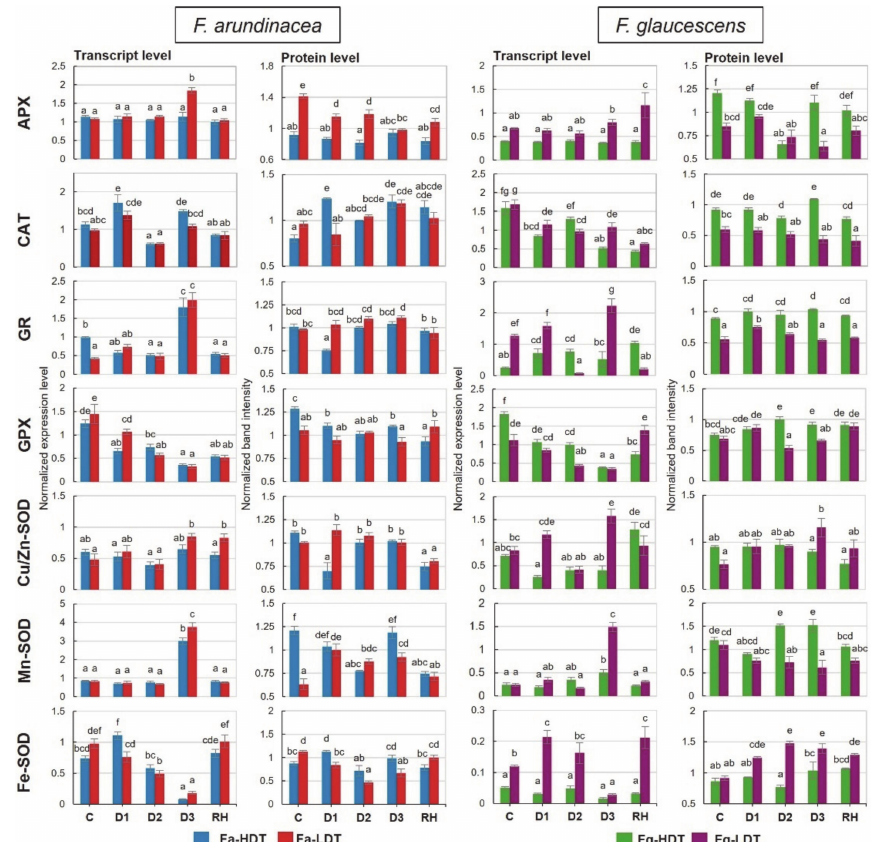
Figure 3. Transcript and protein accumulation level of L-ascorbate peroxidase ( APX ), catalase ( CAT ), glutathione reductase ( GR ), glutathione peroxidase ( GPX ), Cu / Zn superoxide dismutase ( Cu / Zn-SOD ), manganese superoxide dismutase ( Mn-SOD ), and Fe-dependent superoxide dismutase (Fe-SOD ) in two genotypes of F. arundinacea (Fa-HDT, Fa-LDT) and F. glaucescens (Fg-HDT, Fg-LDT) before stress treatment (C), on the 3rd (D1), 6th (D2), and 11th (D3) day of water deficit and 10 days after re-hydration initiation (RH). The transcript accumulation levels of actin and ubiquitin were used as references. Error bars represent the standard errors (SE) of three biological and two technical (transcript level) or three biological (protein level) replicates. Homogeneity groups are denoted by the same letters, according to Fischer LSD test ( p =